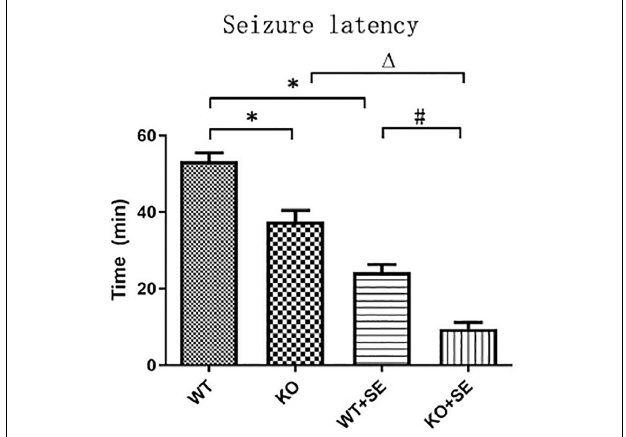
FIGURE 2 | PRG5 KO increased seizure susceptibility, as assessed in the seizure latency test, in which the seizure latencies of the two knockout groups were significantly lower than those of the corresponding control group (KO vs. WT, KO + SE vs. WT + SE). ∗ P < 0.05, compared to the WT group, (cid:77) P < 0.05 compared to the KO group, # P < 0.05 compared to the WT + SE